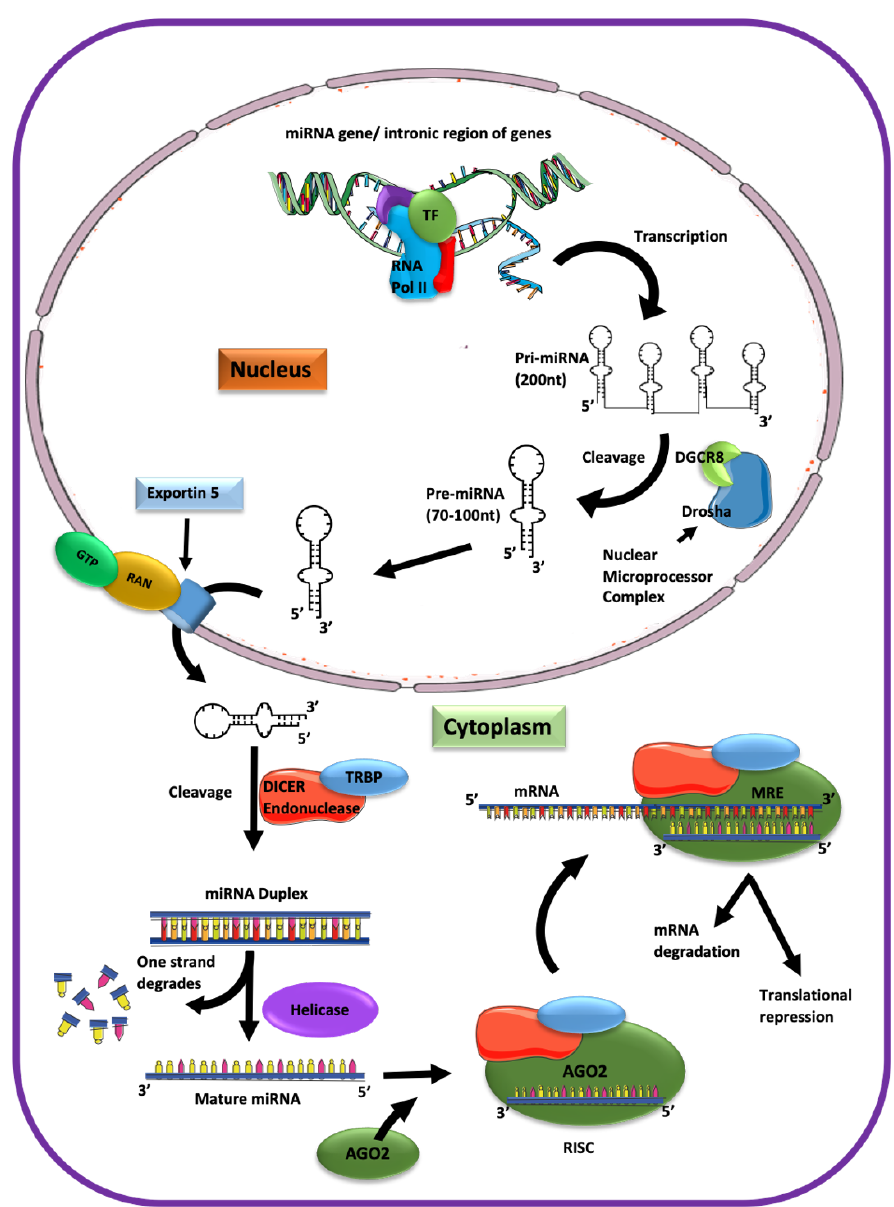
Figure 1. The biogenesis and processing of miRNA. Transcription of the intronic gene region yields the primary (pri)-miRNA that is targeted by the Nuclear Microprocessor Complex containing Drosha and the DiGeorge syndrome critical region gene 8 (DGCR8). The cleaved pre-miRNA is exported from the nucleus by Exportin 5. In the cytoplasm, pre-miRNA is processed by Dicer and Trans-activating response RNA-binding protein (TRBP) into 19-22 nucleotide-long miRNA duplexes. A helicase separates the two strands into a single-stranded mature miRNA recruited into the RNA-induced silencing complex (RISC) that guides the miRNA binding to the miRNA-response element (MRE), usually in the 3’ untranslated region (UTR) of the target gene.